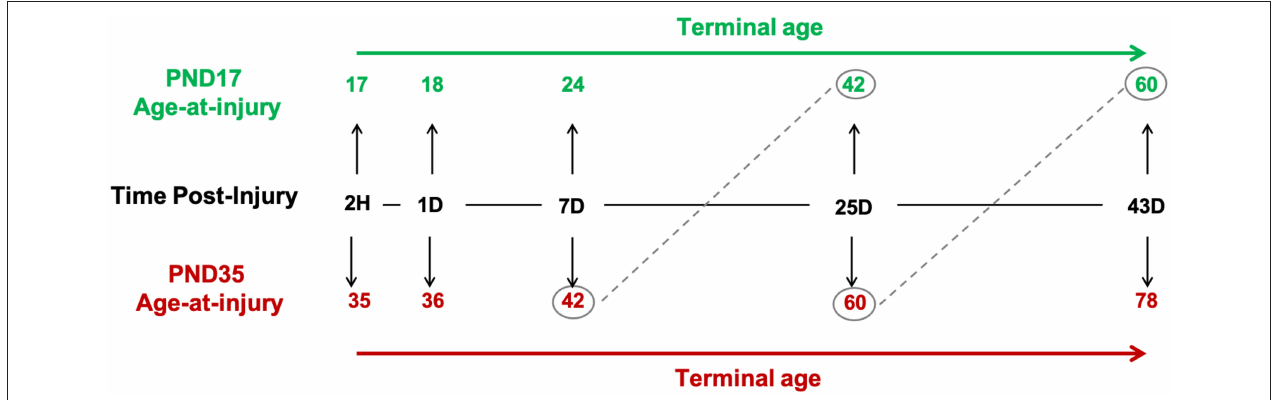
FIGURE 1 | Study design. Post-natal day (PND) 17 and PND35 rats ( n = 75) received midline fluid percussion injury or sham surgery. In three cortical regions (peri-injury, S1BF, perirhinal), we investigated the glial response relative to age-at-injury (PND17/PND35), time post-injury (2H, 1D, 7D, 25D, and 43D), and post-natal-age, such that rats injured at PND17 or PND35 were compared at the same post-natal-age (e.g., PND17 + 25D post-injury = PND42; PND35 + 7D post-injury = PND42).